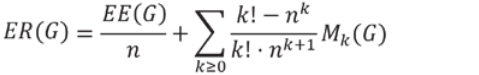
Table 2. The values of the fitting parameter α from formula (11) for which the best correlation coefficients are obtained. n